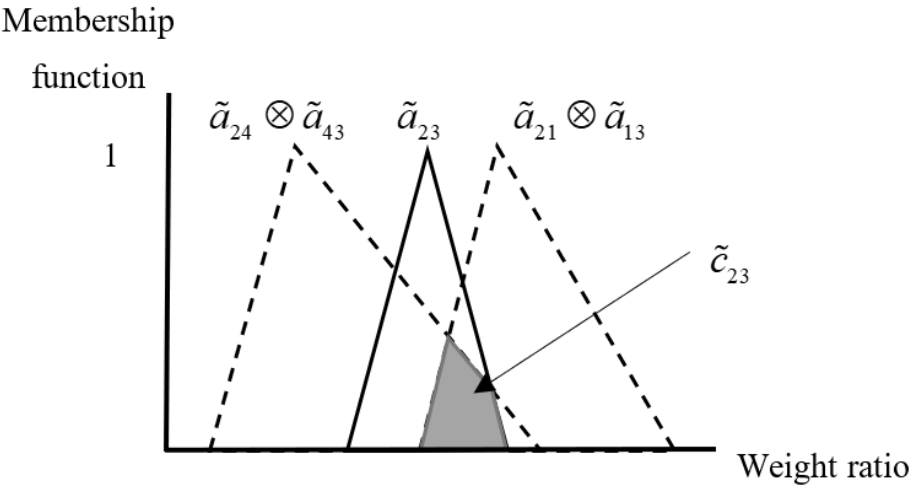
a  Figure 1. The consistent comparison ratio for (cid:101) a 23 23